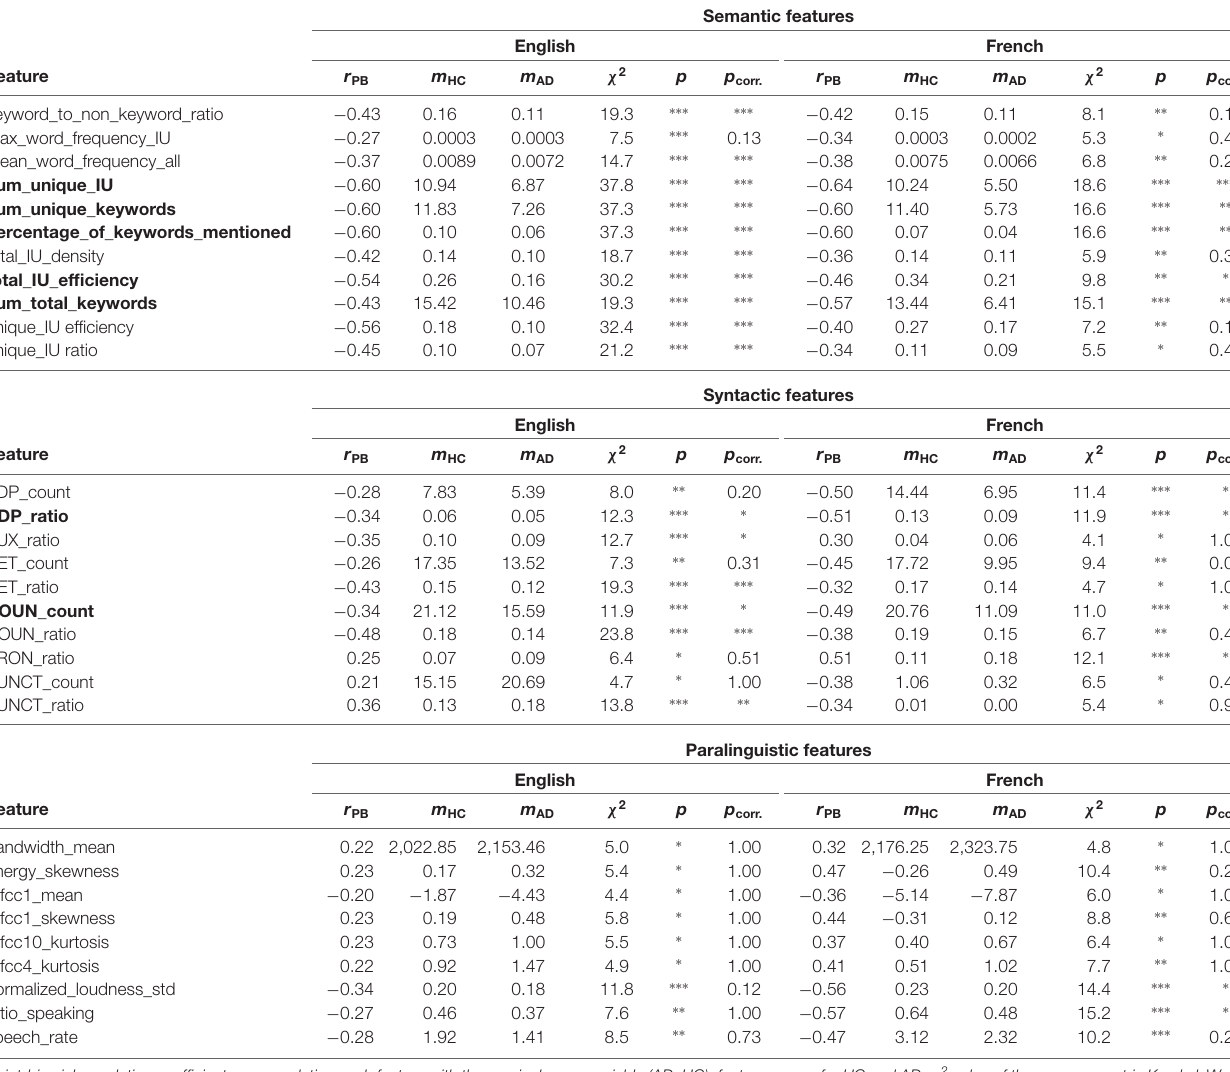
TABLE 3 | Statistics as per feature set and